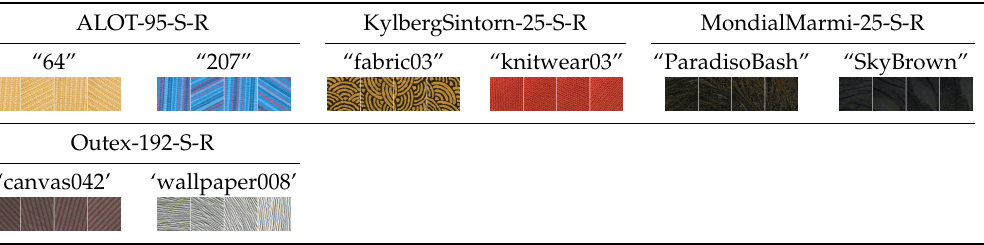
Figure 5. Group #5: Stationary textures with rotation (Section 3.2.5).